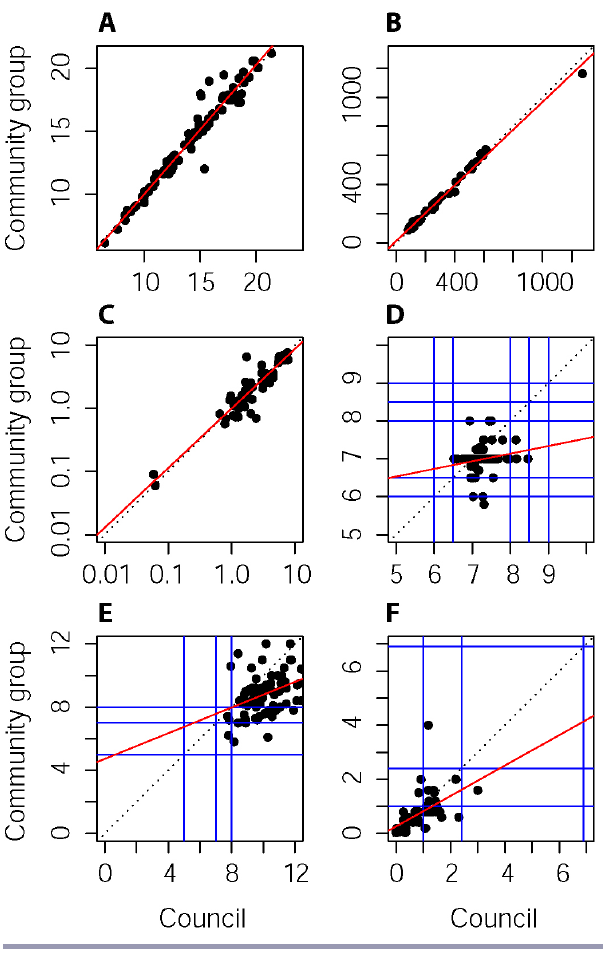
Fig. 1 . Relationships between community group and regional council (“council”) data for (A) Temperature (°C), (B) Electrical conductivity (μS/cm), (C) Visual clarity (m) on log scale, (D) pH, (E) Dissolved oxygen (mg/L), (F) Nitrate (mg/L). Solid line through data indicates correlation. Dotted line indicates 1:1 relationship. Horizontal and vertical lines show condition bands according to New Zealand’s National Objectives Framework.